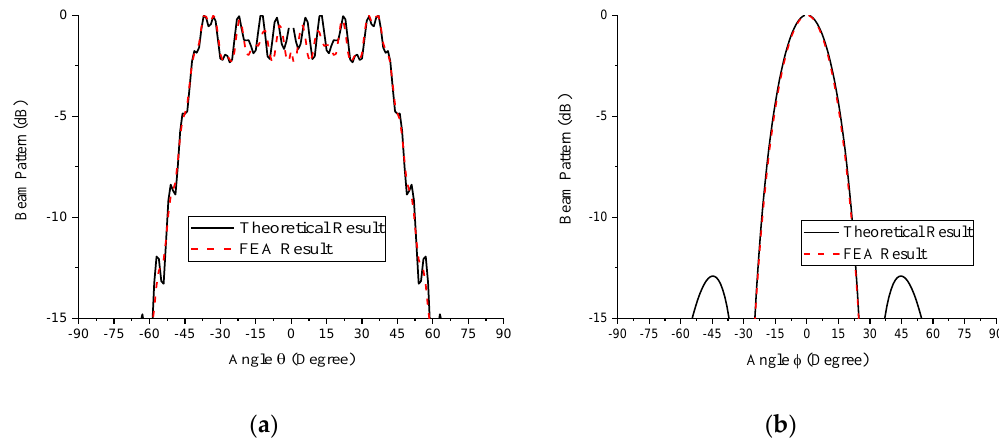
Figure 8. Two-dimensional theoretical beam pattern of the 5 × 55 conformal array compared with those from the FEA: ( a ) M-subarray part; ( b ) N-subarray part.